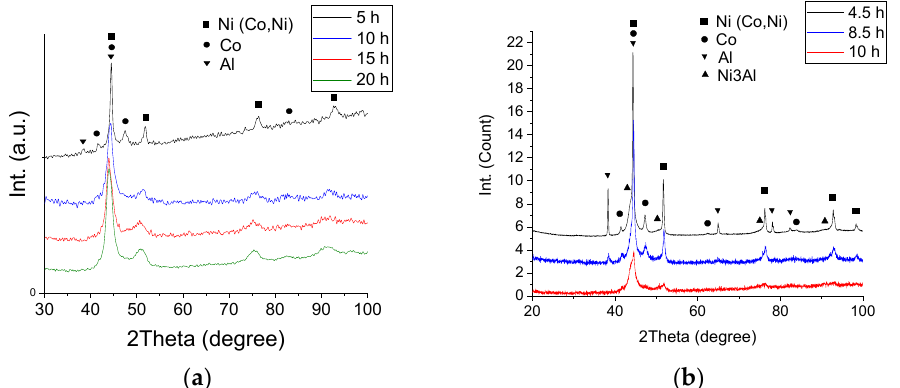
Figure 4. XRD-patterns of Ni 36 Al 27 Co 37 powders produced by mechanical alloying in planetary mill at 200/ − 400 mode ( a ), and in attritor ( b ).